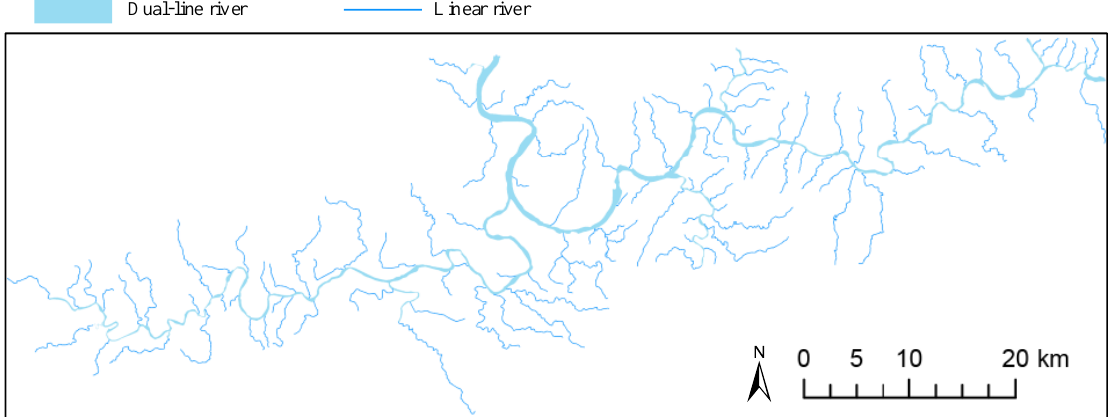
Figure 11. Original river data in the experimental area.